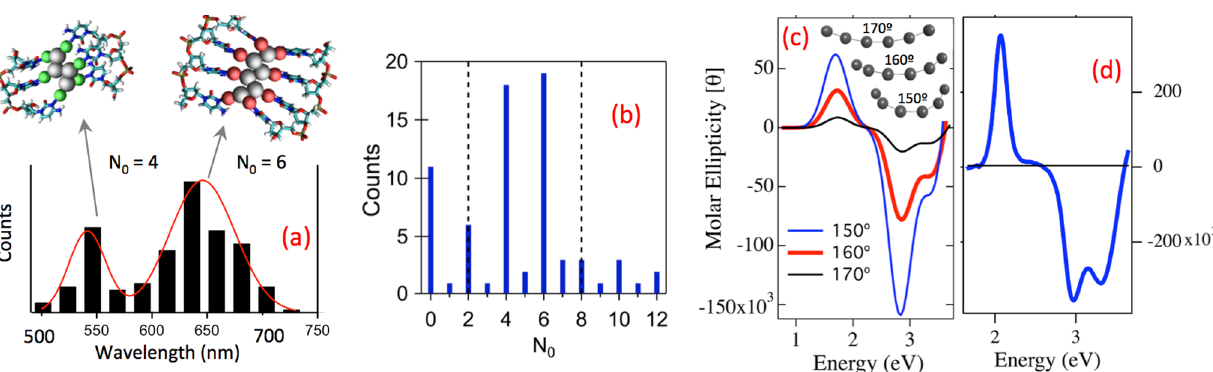
Figure 6. Magic colors and magic number neutral cluster sizes in ( a , b ) Ag N -DNA and chiroptical properties of pure ( c , d ) Ag N -DNA. (Adapted with permission from references [26,42]). ( a ) Fluorescence colors measured for Ag N -DNA formed on many different DNA templates exhibit “magic colors”: high green abundances near 540 nm and high red abundances near 630 nm [26]; ( b ) N 0 = 4 and 6 are magic (highly abundant) cluster sizes across all Ag N -DNA with composition determined by ESI-MS [26]. Dashed lines: spherical “superatom” magic numbers 2 and 8 are not magic for Ag N -DNA, indicating non-spherical (rod) shapes for the silver clusters; ( c ) Calculated circular dichroism spectra for bare, chiral Ag cluster rods show a consistent pattern of positive and negative peaks for different curvatures [42]; ( d ) CD data on pure Ag N -DNA show the same peak pattern as theory